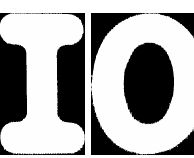
Figure 5. Images with low linear correlation presenting PCC = 0.1605.